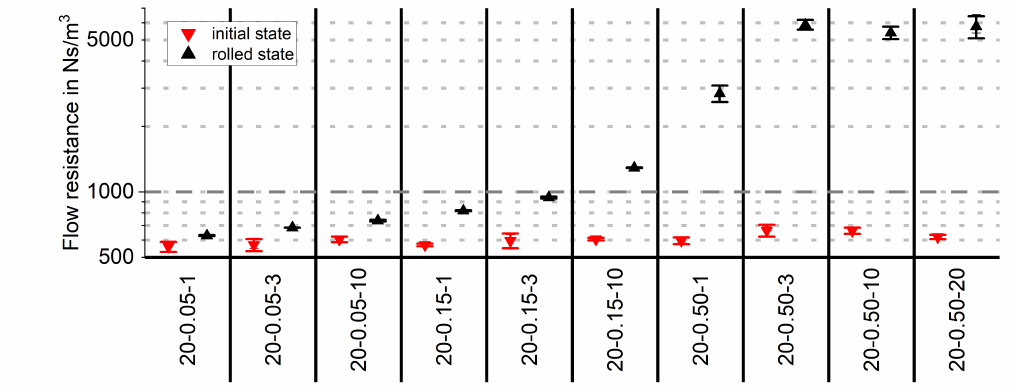
Figure 17. Flow resistance (mean value with standard deviation) for samples with 20mm initial thickness.